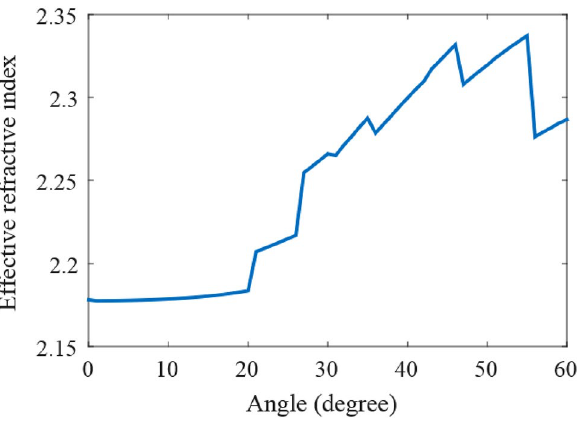
Figure 3. Effective refractive index of a slot with 2 µm length as a function of incident light